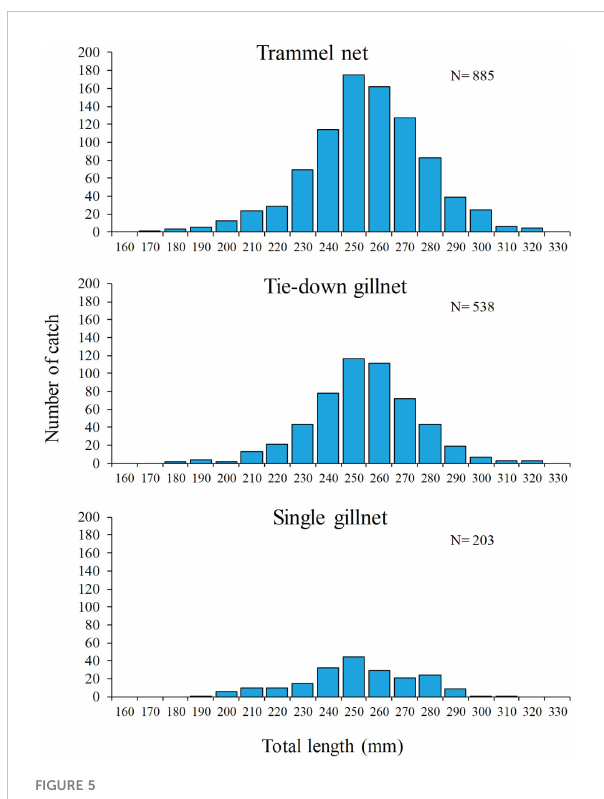
FIGURE 5 The distribution of the number of black fi n fl ounder caught in three types of gillnets as a function of their total